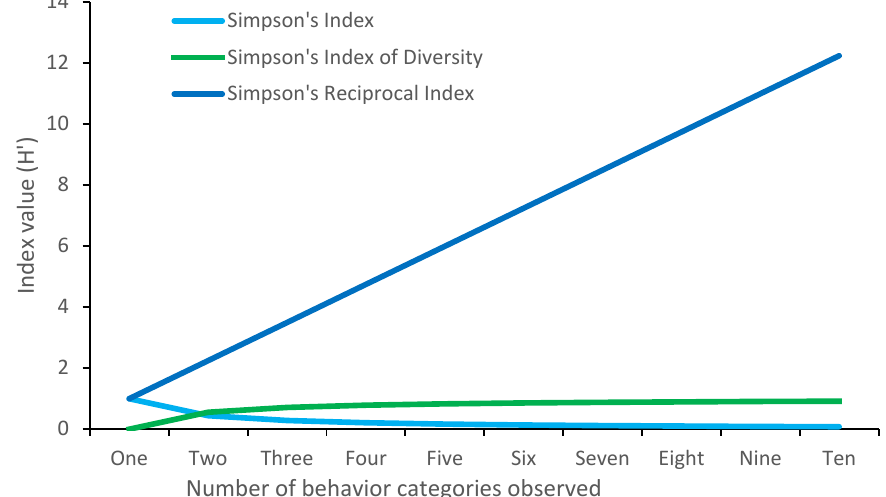
Figure 2. Comparison of Simpson’s index, Simpson’s index of diversity, and the Simpson’s Reciprocal index, using an identical dataset where all behaviors are equally well represented.